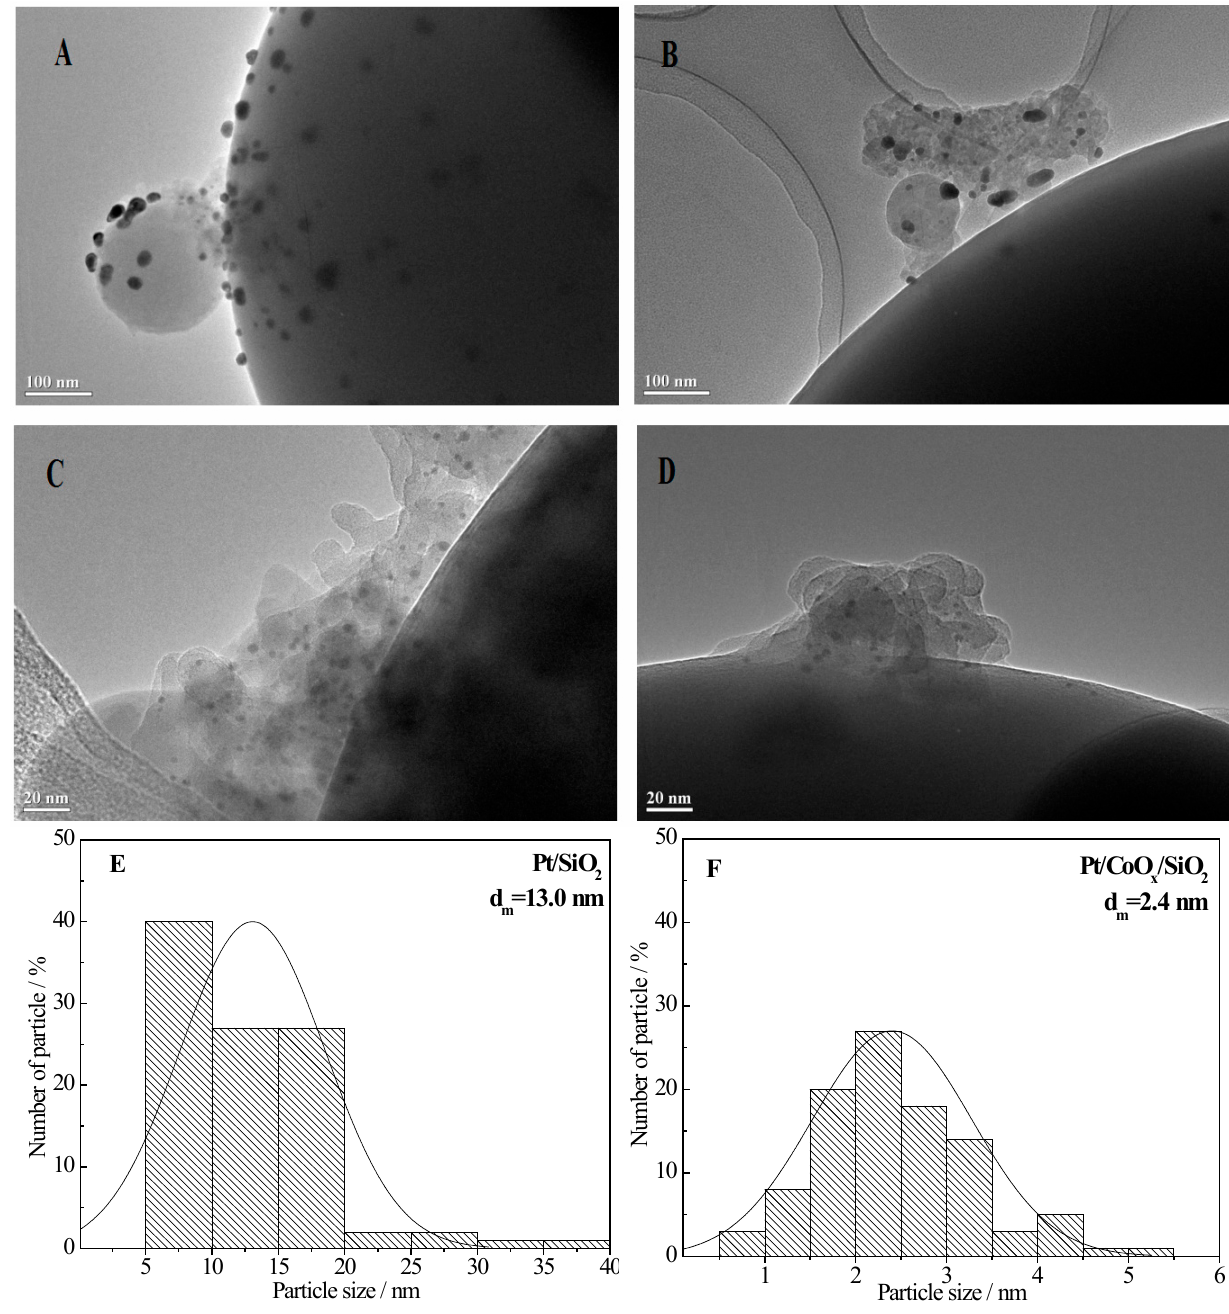
Figure 8. TEM images of the spent Pt/SiO 2 ( A , B ) and Pt/CoO x /SiO 2 ( C , D ) catalysts. Size distributions of Pt particles of spent Pt/SiO 2 ( E ) and Pt/CoO x /SiO 2 ( F